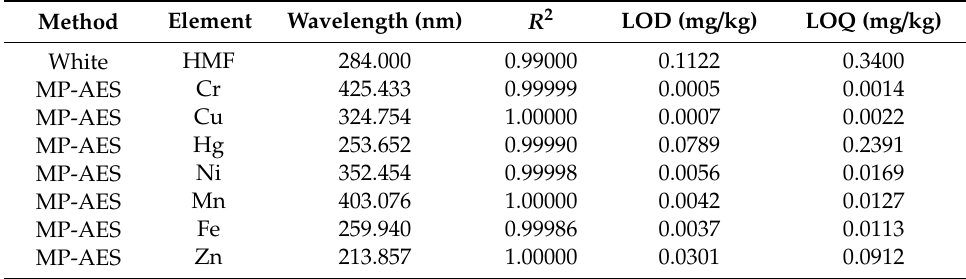
Table 1. Hydroxymethylfurfural (HMF), mineral and toxic metal wavelength of detection,